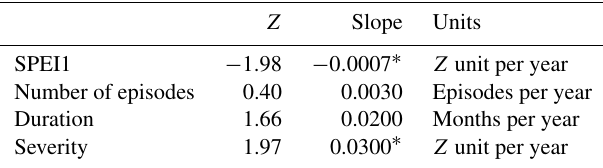
Table 2. Trend analysis according to Mann–Kendall (MK) tests of prewhitened time series and Sen’s slope for the 1-month SPEI se- ries and the number of episodes that start per year, their duration, and their severity. Statistically significant trends at ( p < 0 . 05) and Z scores are marked with an asterisk. Period of 1980–2017. Z